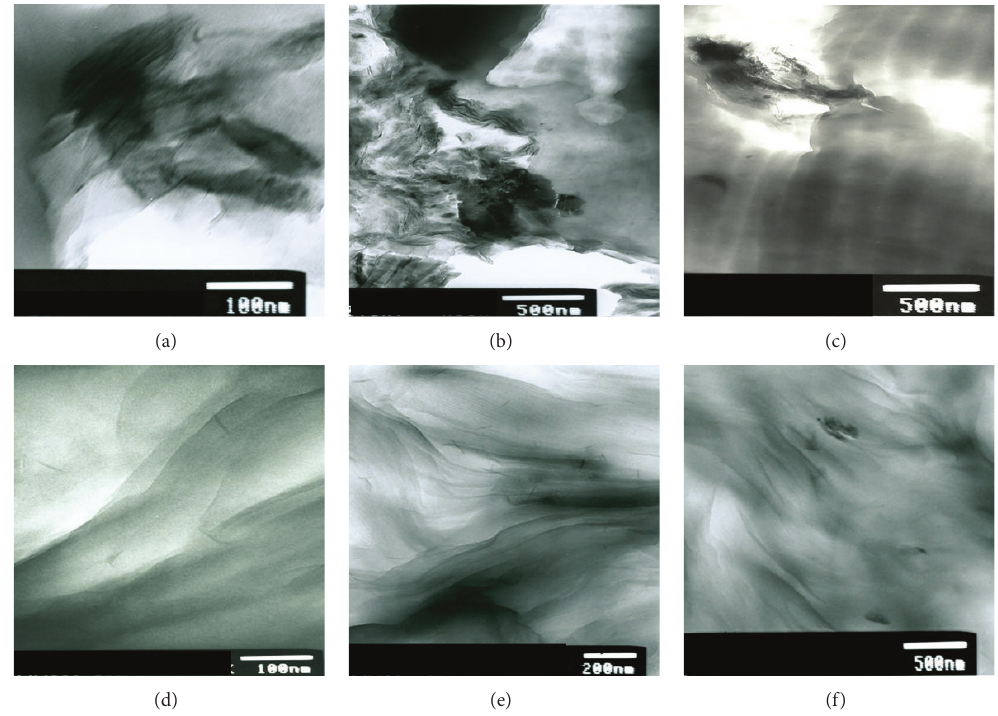
with 0.6 wt% (X100 (a), X500 (b), and X500 (c)) and 2 wt% (X100 (d), X200 (e), and X500 HDTMA/PVA